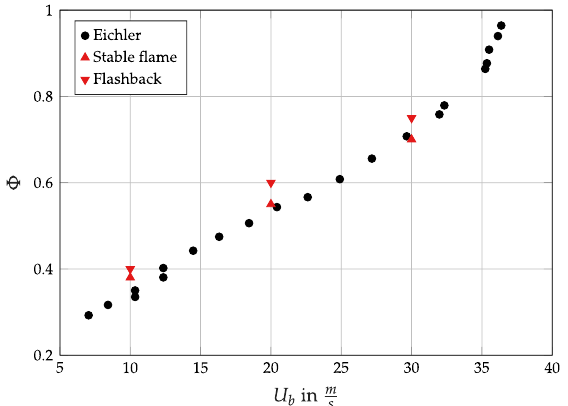
Figure 4. Atmospheric flashback limits obtained from the reactive LES compared to experimental flashback limits of Eichler et al. [16].